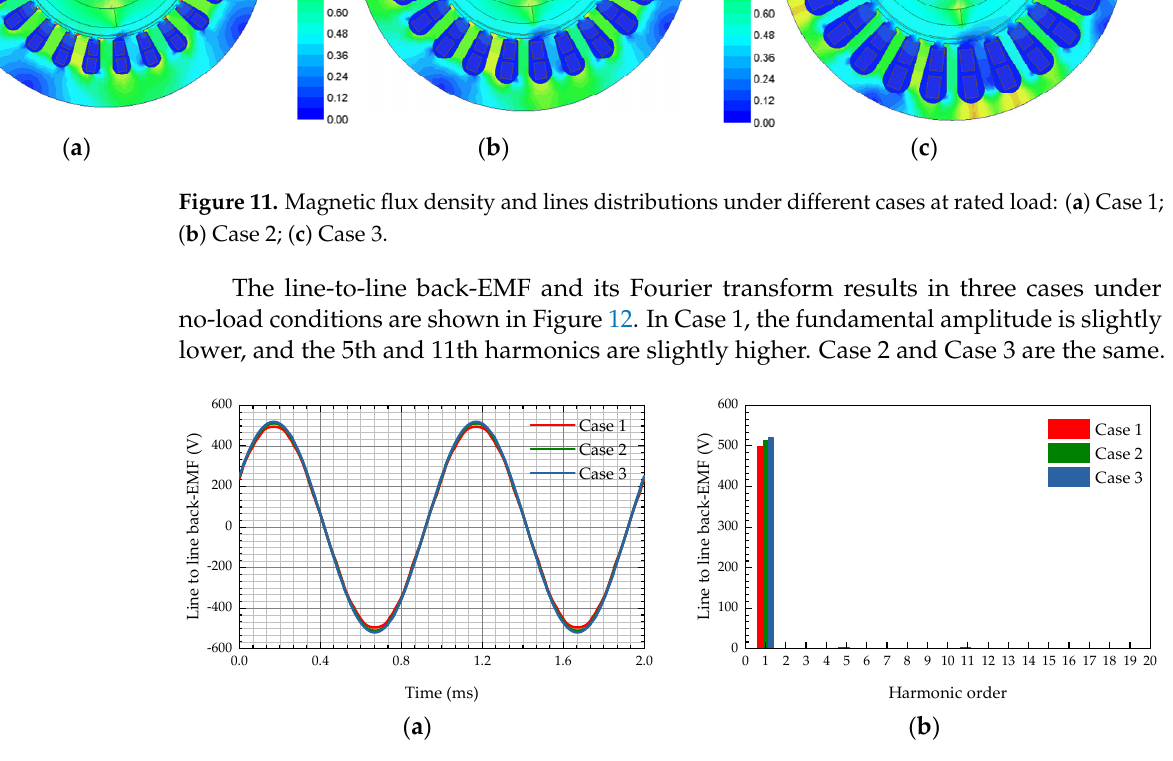
( d ) Figure 13. Radial air ‐ gap flux density and Fourier transforms under three cases at no load and rated load: ( a ) radial air ‐ gap flux density at no load; ( b ) Fourier transforms results at no load; ( c ) radial air ‐ gap flux density at rated load; ( d ) Fourier transforms results at rated load. 4.2. Losses Comparative Analysis